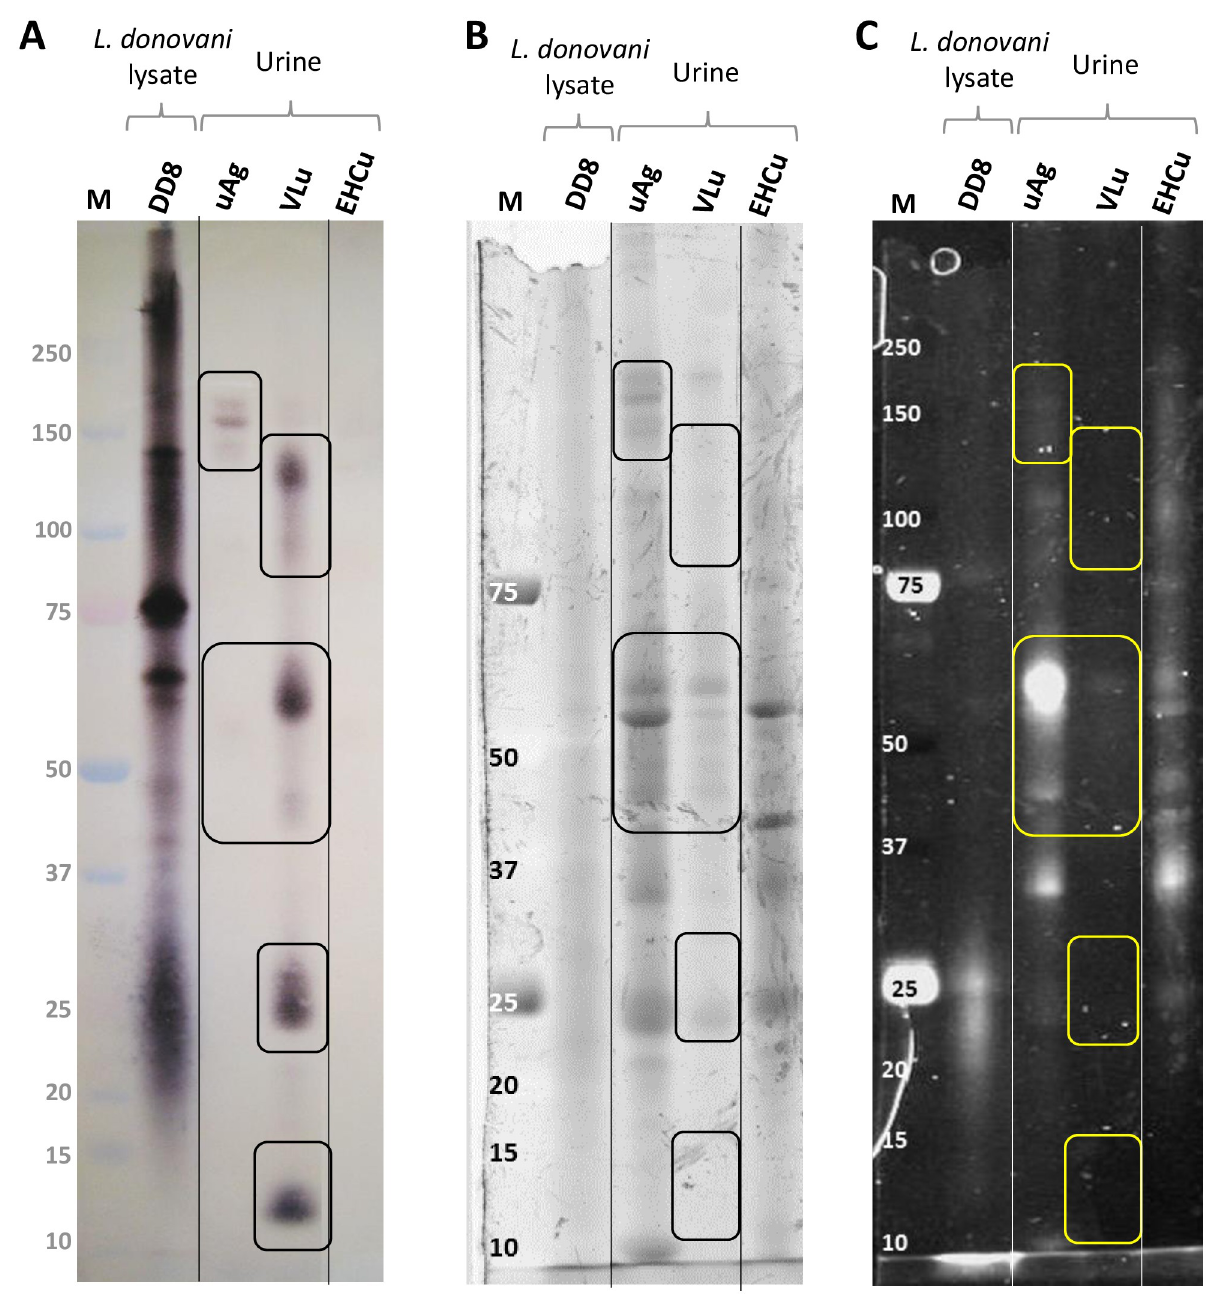
Fig 2. Sudanese VL patients’ urine (VLu) and immunocaptured urine antigen (uAg) detected by rabbit anti- L . donovani DD8 and -LV9 by western blot. Regions submitted to mass spectrometry are broadly indicated by boxes. A) western blot, B) corresponding gel stained for proteins, C) the same gel as B, stained for carbohydrates. Molecular mass marker (M) sizes in kiloDaltons. Lanes are: lysate antigen of L . donovani strain DD8; uAg, VL urine material eluted from an anti- L . donovani DD8 immunochromatography column; VLu, concentrated VL urine; EHCu, concentrated urine from endemic healthy controls. Vertical lines indicate where the photographs were spliced to remove non-relevant lanes from the original images, and realigned based on the molecular weight marker.